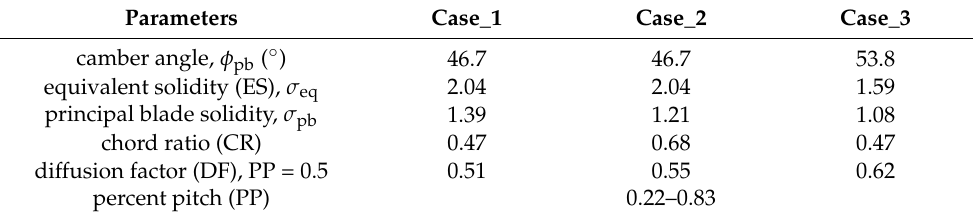
Table 3. Geometry parameters of three splittered cascades for performance sensitivity analyses.